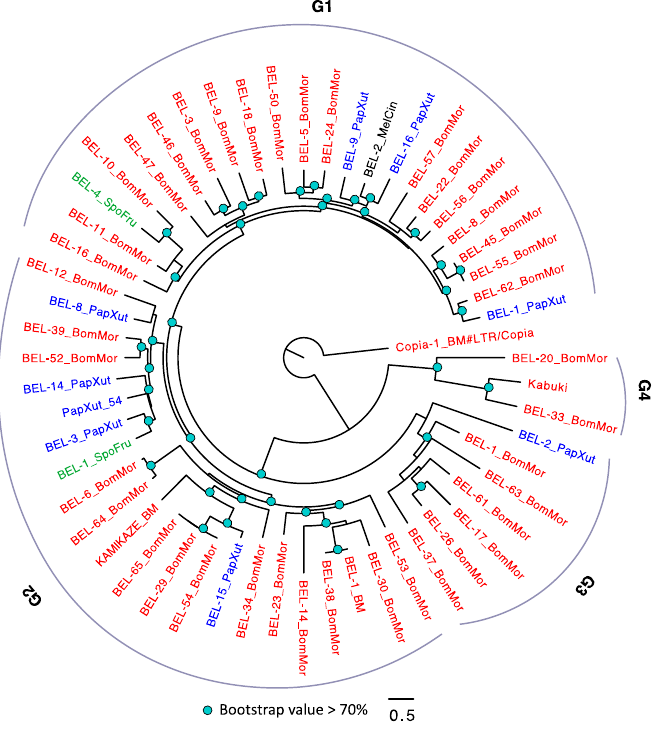
Figure 4. The phylogeny of BEL/Pao in Lepidoptera . The BEL/Pao were arbitrarily divided into four groups (G1–4). TEs with BM (annotated in Repbase) or BomMor (annotated in this study) suffixes are from B. mori (red name); TEs with PapXut, MelCin and SpoFru are from P. xuthus (blue name), M. cinxia (black name) and S. frugiperda (green name). Kabuki is from B. mori and has been annotated in BmTEdb [64]. Only nodes with bootstrap value not lower than 70% were indicated. Copia-1_BM is the outgroup.